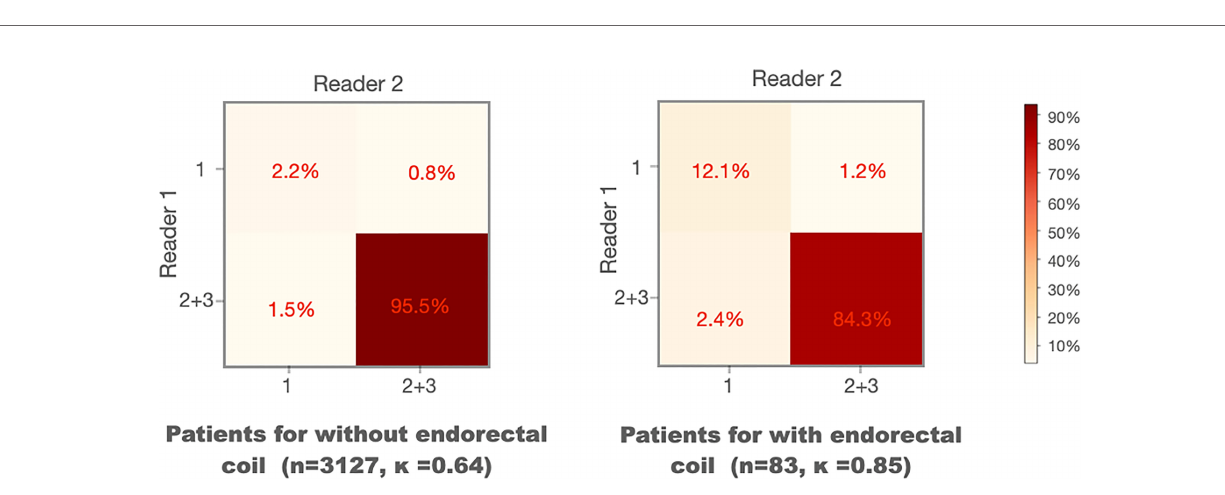
FIGURE 5 | Confusion matrices of the visual grades of segmentation on MRI scans with and without endorectal coils. Kappa coef fi cient ( k ) is used to measure the inter-rater variability between the two readers.